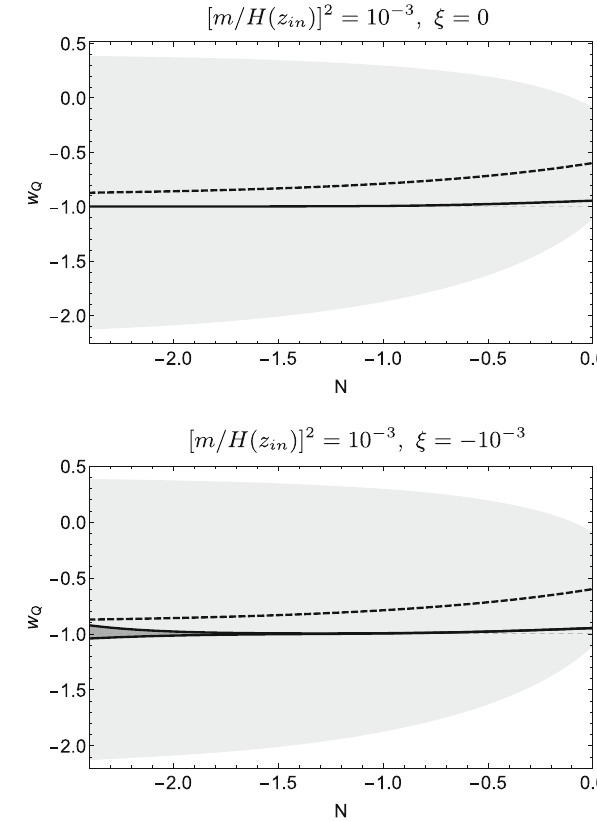
Fig. 5 The DE equation of state parameter w DE as a function of N =− ln ( 1 + z ) . The solid black curve shows the quantum backreaction equation of state parameter, w Q ( N ) , the dashed curve shows w DE ( N )